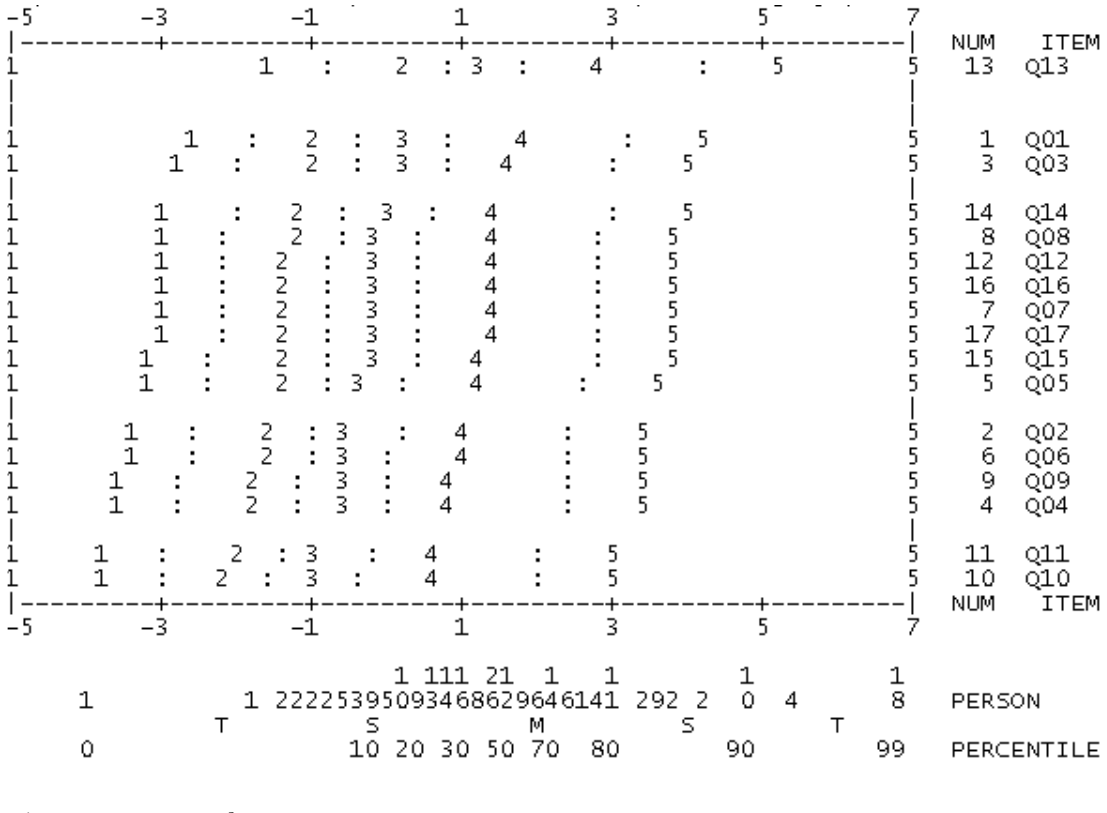
Figure 3 . Construct key